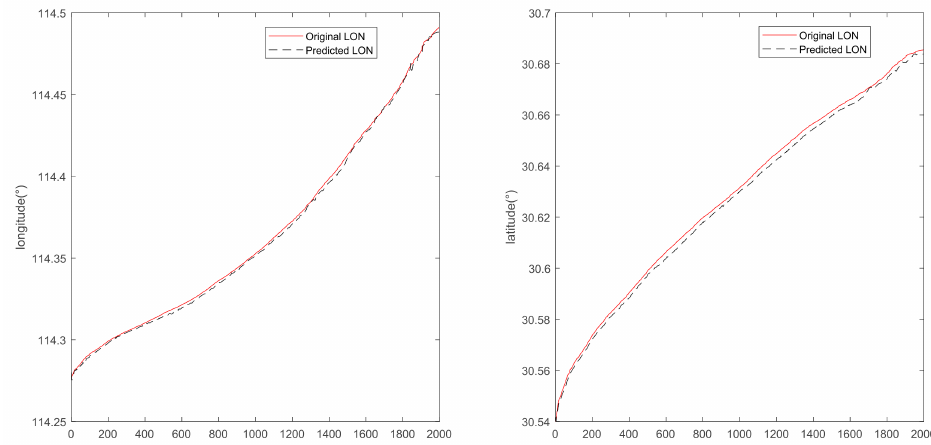
Figure 9. Prediction results of LON and LAT of ship-2.